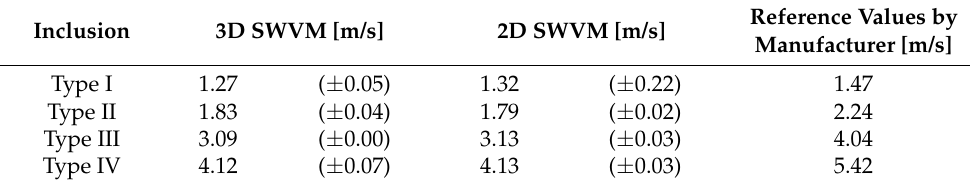
Table 1. Mean ( ± SD) shear wave velocity of the four inclusion types in the elastography tissue phantom. Calculated mean values in the reconstructed 3D volume (3D SWVM) and 2D images (2D SWVM) with respective standard deviations in comparison to the reference values provided by the manufacturer.